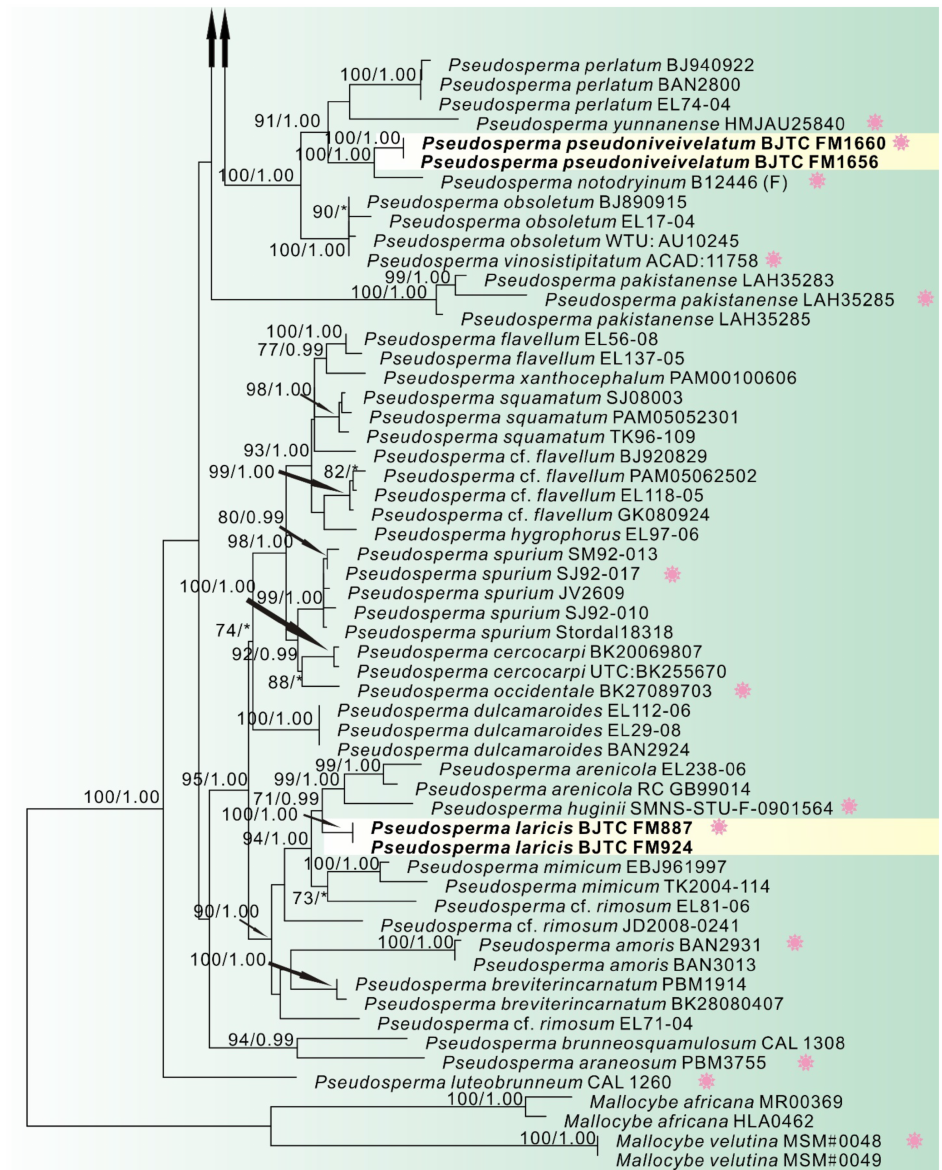
Figure 2. Phylogeny derived from Maximum Likelihood analysis of the ITS/LSU sequences from Pseudosperma and related genera in the family Inocybaceae. Mallocybe velutina and M . africana were employed to root the tree as an outgroup. Numbers representing likelihood bootstrap support (BS ≥ 70%, left) and significant Bayesian posterior probability (BPP ≥ 0.99, right) are indicated above the nodes. New sequences are highlighted in black bold. The red symbol represents the type